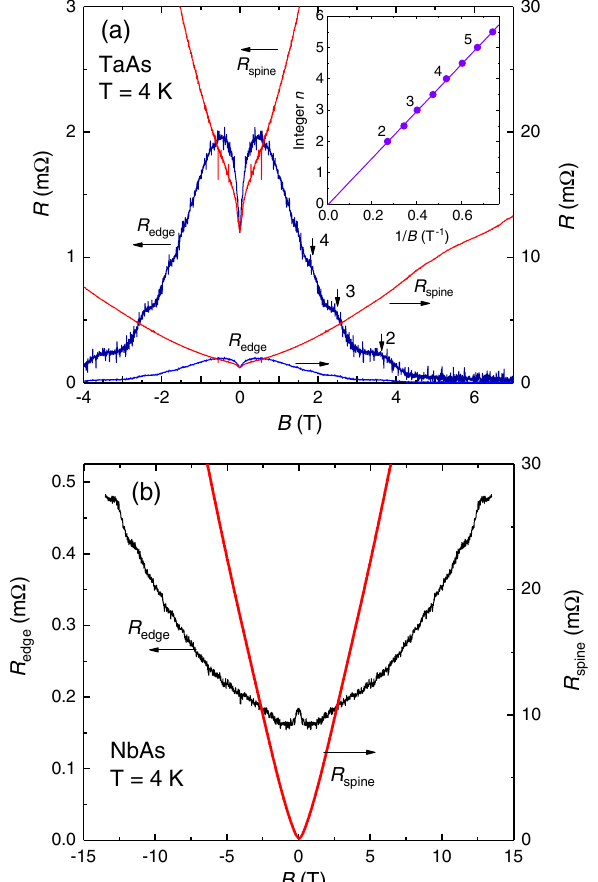
FIG. 6. The squeeze test applied to the Weyl semimetals TaAs and NbAs. Panel (a) shows field profiles of R and R in edge spine TaAs (measured at 4 K) in an in-plane, longitudinal B along the “ spine ” of the sample. The crystal is a thin plate of dimension 2 . 0 × 1 . 5 × 0 . 2 mm 3 with spacing l between voltage contacts of 1.5 mm, and current-contact diameters d c ∼ 80 μ m. Between 0.5 T and 6 T, R (thick blue curve, left axis) is observed to edge decrease by a factor of about 50 to values below our resolution. However, the spine resistance R (red curve) increases by a spine factor of 7.8 (the right axis replots R and R reduced by a spine edge factor of 10). This implies that the pronounced decrease in R edge is an artifact caused by current jetting, just as observed in pure Bi. The Landau level indices n of the weak SdH oscillations are indicated by vertical arrows. The index plot (inset) shows that n ¼ 1 is reached at B ¼ 7 . 04 T, whereas 1 = μ ∼ 0 . 06 T. Panel Q (b) shows field profiles of R (black curve, left axis) and R edge spine (red curve, right axis) measured in NbAs at 4 K in longitudinal B (crystal size 1 . 5 × 1 . 0 × 0 . 4 mm 3 ). The small negative LMR anomaly near zero B in R has been invoked as evidence for the edge chiral anomaly even though R increases above 1.2 T. By edge contrast, R increases monotonically at a very steep rate spine (note the difference in vertical scales). In both high-mobility semimetals, classical current-jetting effects onset near 0.4 T, well below B Q . This makes the chiral anomaly virtually unobservable by